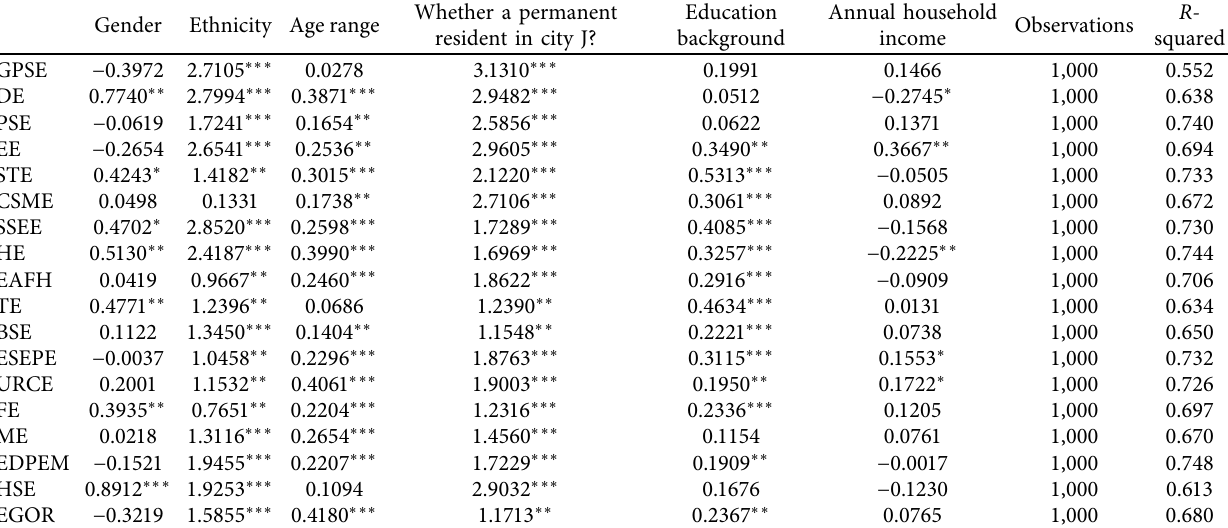
Table 7: Incremental regression of the group characteristics and overall budget